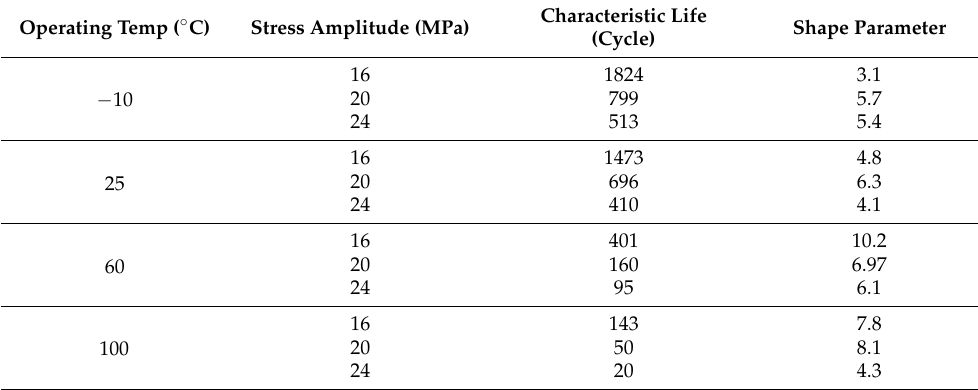
Table 2. Result summary of the reliability